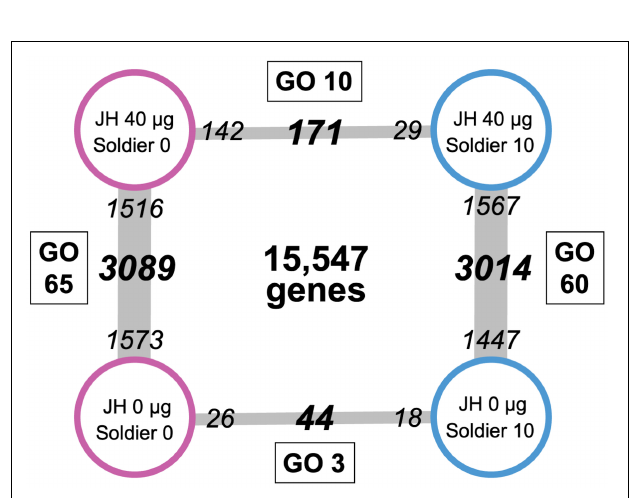
FIGURE 2 | Numbers of differentially expressed genes (DEGs, bold italic) between each category. Small italic numerals indicate the numbers of upregulated genes in each category. Gene numbers between juvenile hormone (JH) III and acetone treatments (3,014 in soldier presence, 3,089 in soldier absence) were much larger than those between soldier presence and absence (171 in JH treatments, 44 in acetone treatments). Numbers of significant gene ontology (GO) terms of the DEGs are indicated in